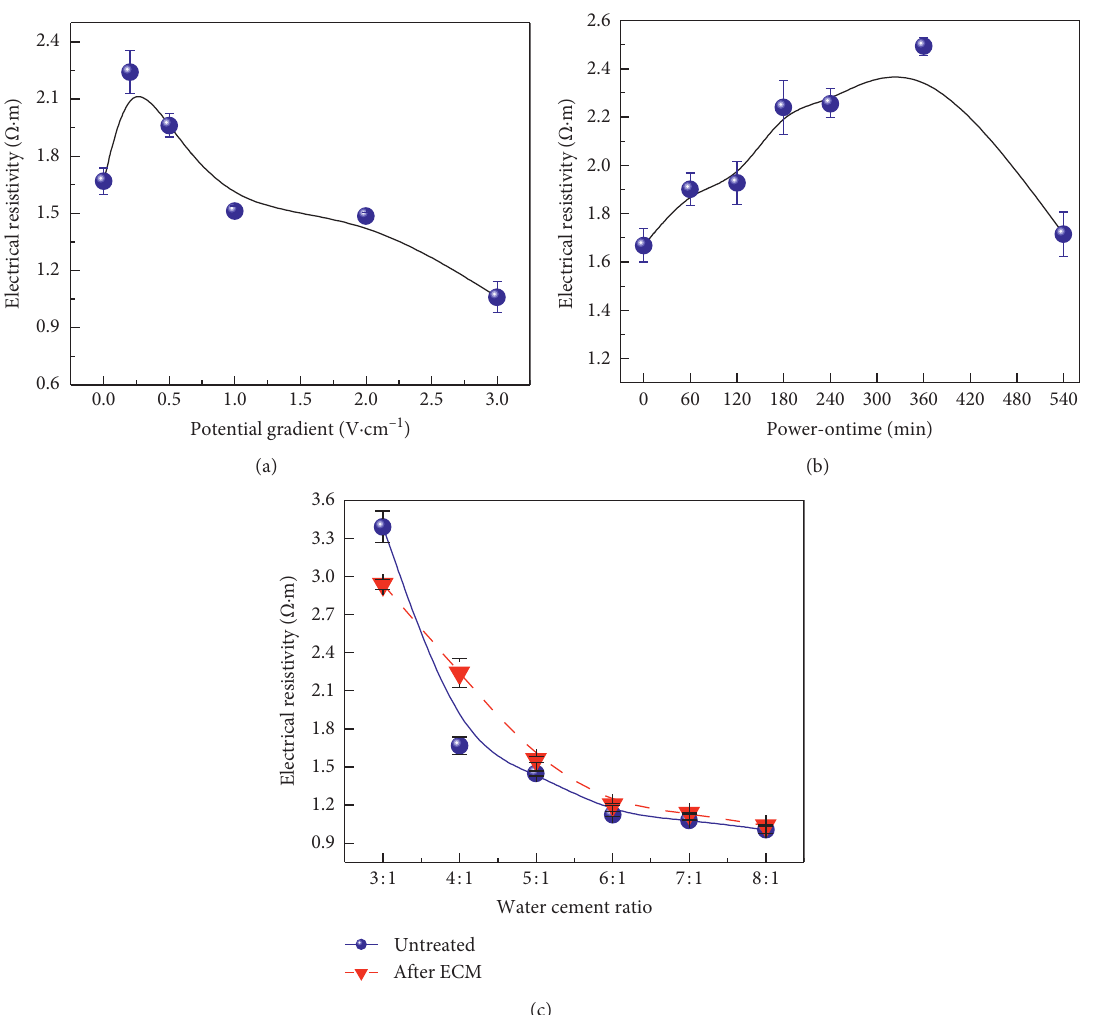
Figure 13: The change in electrical resistivity of the HWBM samples after electrochemical modification: (a) potential gradient; (b) power-on time; and (c) W / C .